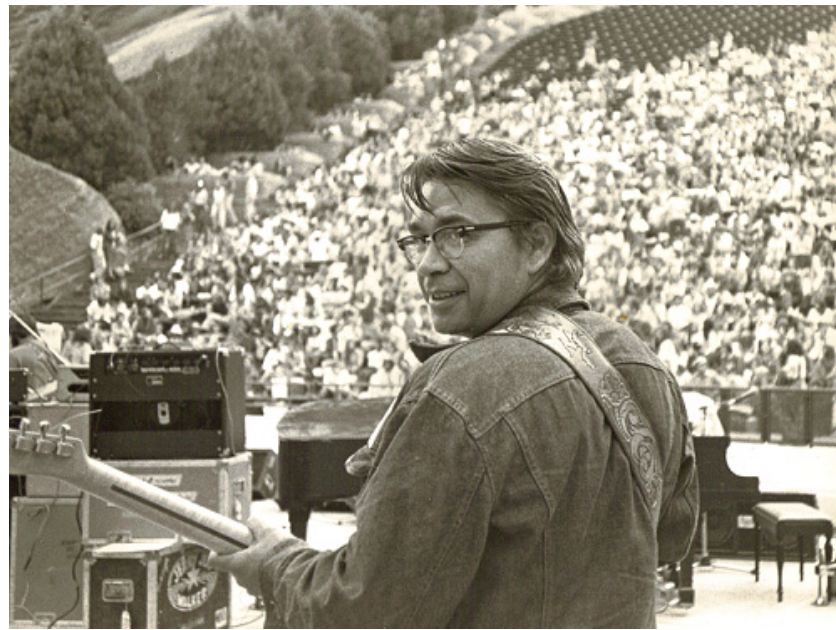
Figure 3. Vine Deloria, Jr. at Red Rocks Amphitheater, Golden, Colorado, 1976. Photograph by Gary P. Nunn. Author’s collection.